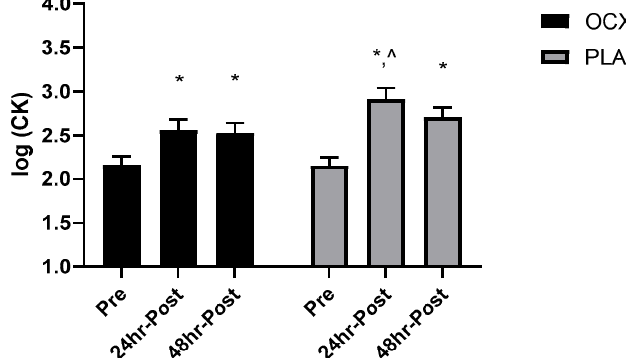
Figure 1. Bar charts displaying the mean and standard error for the log transformation of the plasma creatine kinase (CK) in the Oceanix (OCX) and placebo (PLA) conditions collected prior to the supplement period (Pre), one day, and two days following the supervised cross-training bout (24 h Post and 48 h Post, respectively). * = significantly greater than Pre ( p < 0.05). ^ = significantly greater than OCX ( p < 0.05).